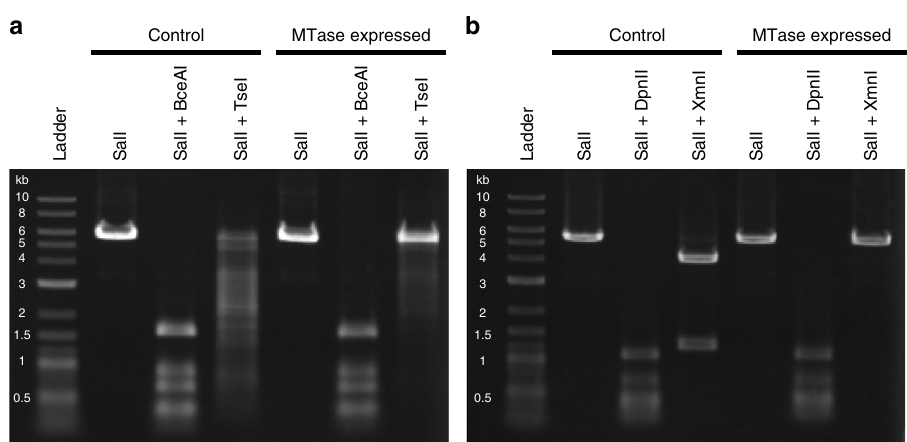
Fig. 3 REase digestion assays. a Assay of the EMGBS3_12600 gene (and EMGBD1_09320, which has the same amino-acid sequence). BceAI and TseI were used, where the plasmid contained 12 (ACGGC) and 21 (GCWGC) target sites, respectively. Plasmid DNAs were linearized using SalI before the assay. An NEB 2-log DNA ladder was employed as a size marker. b Assay of the EMGBS15_03820 gene. DpnII and XmnI were used, where the plasmid contained 27 (GATC) and 2 (GAANNNNTTC) target sites, (Supplementary Table 4): ACG A G was actually detected as the TAGGG A B was excluded), and this difference could be due to methylated motif in E. coli transformed with EMGBS10_10070, E. coli -speci fi c conditions (e.g., cofactors and sequence biases), and we named the protein M.ObaBS10I. In the case of insuf fi cient data, inaccuracy of the methylated motif detection EMGBD2_08790, the detected TAHGG A B motif was almost method. Regardless of this minor difference, we concluded that the same, but a subset of the estimated TANGG A B motif (i.e., EMGBD2_08790 is a novel MTase gene responsible for